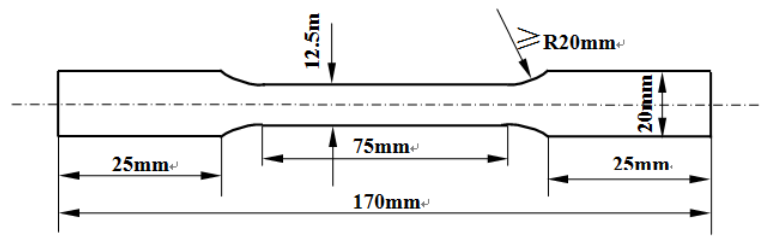
Figure 1. Size of the tensile specimens with a thickness of 2.8 mm.